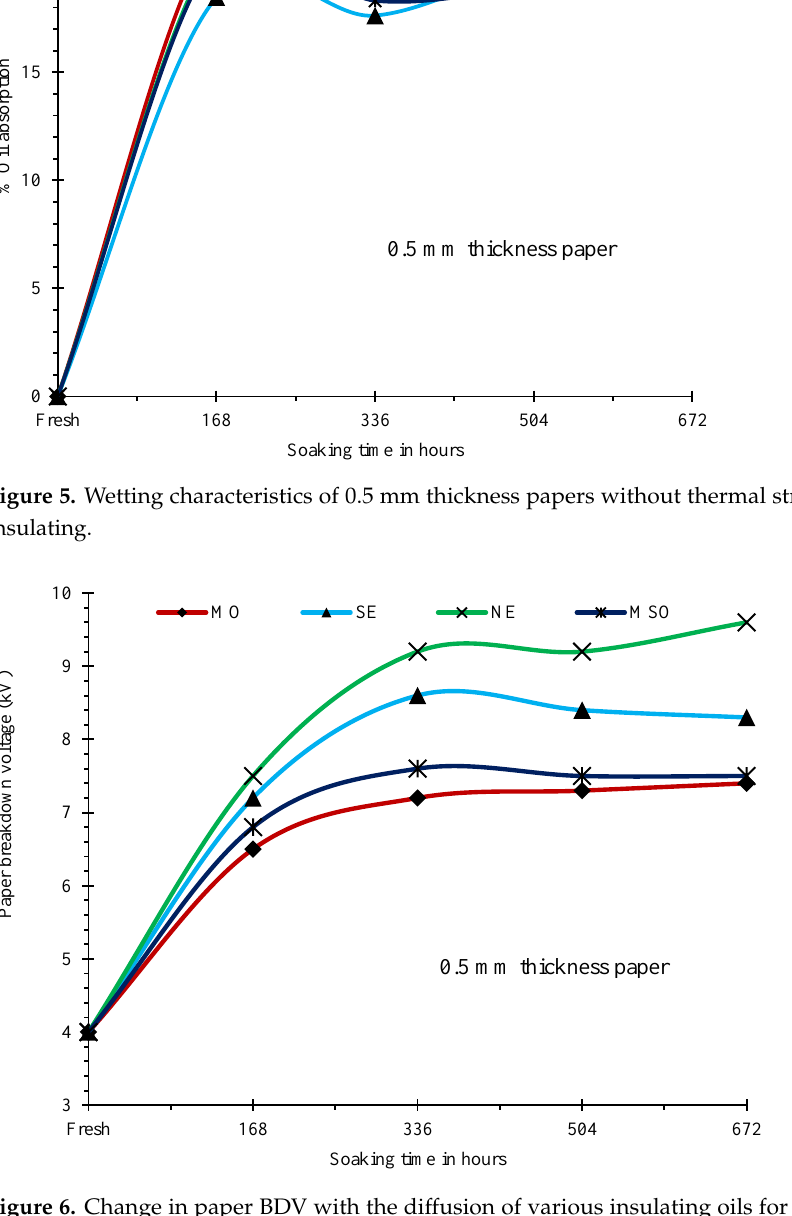
Figure 6. Change in paper BDV with the diffusion of various insulating oils for 0.5 mm thickness papers without thermal stresses oils.